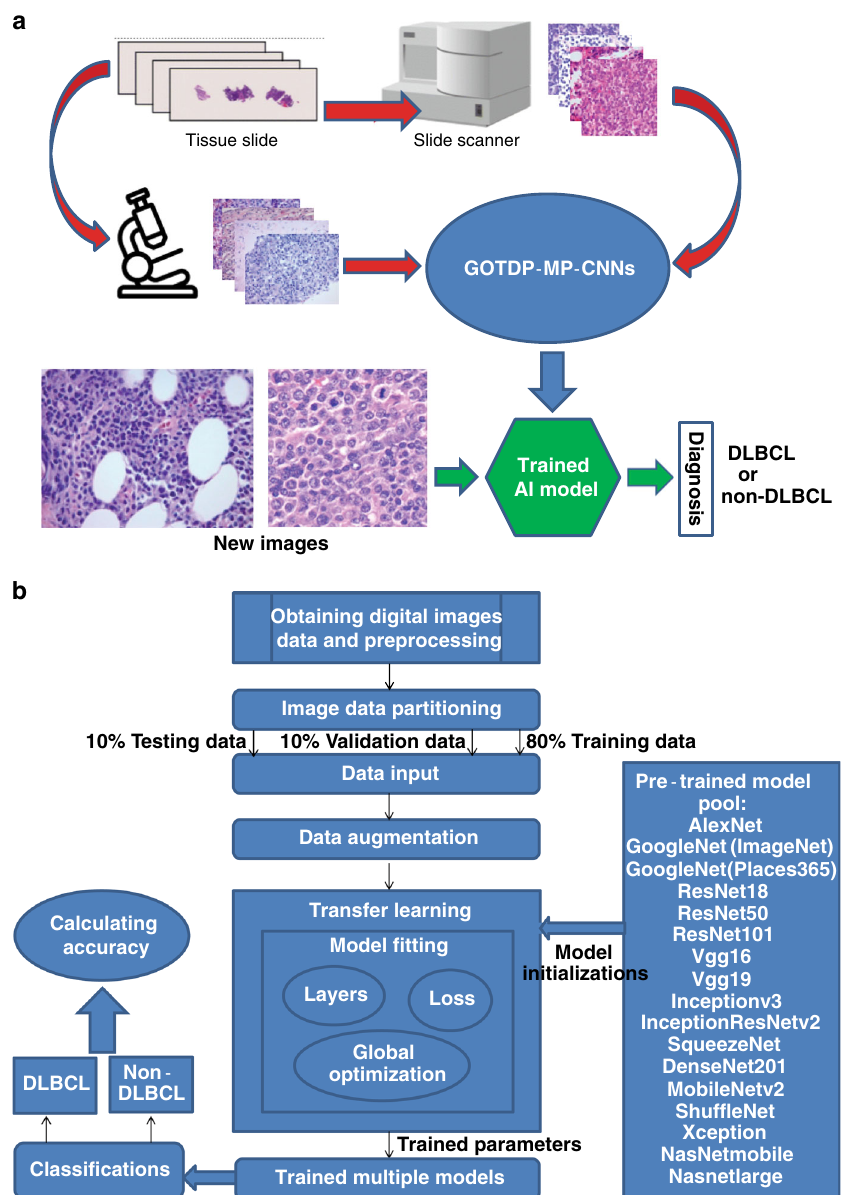
Fig. 1 Strategies for the establishment of AI models for analysis of pathologic images. a Work fl ow of the system. Photographs of the slide images and scanned images of the entire slides for DLBCL and non-DLBCL were used for establishing AI models. b Overview of data fl ow implemented and components of the GOTDP-MP-CNNs. 17 CNNs [AlexNet, GoogleNet(ImageNet), GoogleNet(Places365), ResNet18, ResNet50, ResNet101, Vgg16, Vgg19, Inceptionv3, InceptionResNetv2, SqueezeNet, DenseNet201, MobileNetv2, Shuf fl eNet, Xception, NasNetmobile, Nasnetlarge] were utilized as a whole in generation of our AI models, and the transfer learning was used to optimize the fi tness of the data. A speci fi c AI model was established by training 80% of total samples with 10% of them used for model validation and the remaining 10% of the samples for testing diagnostic accuracy of the established